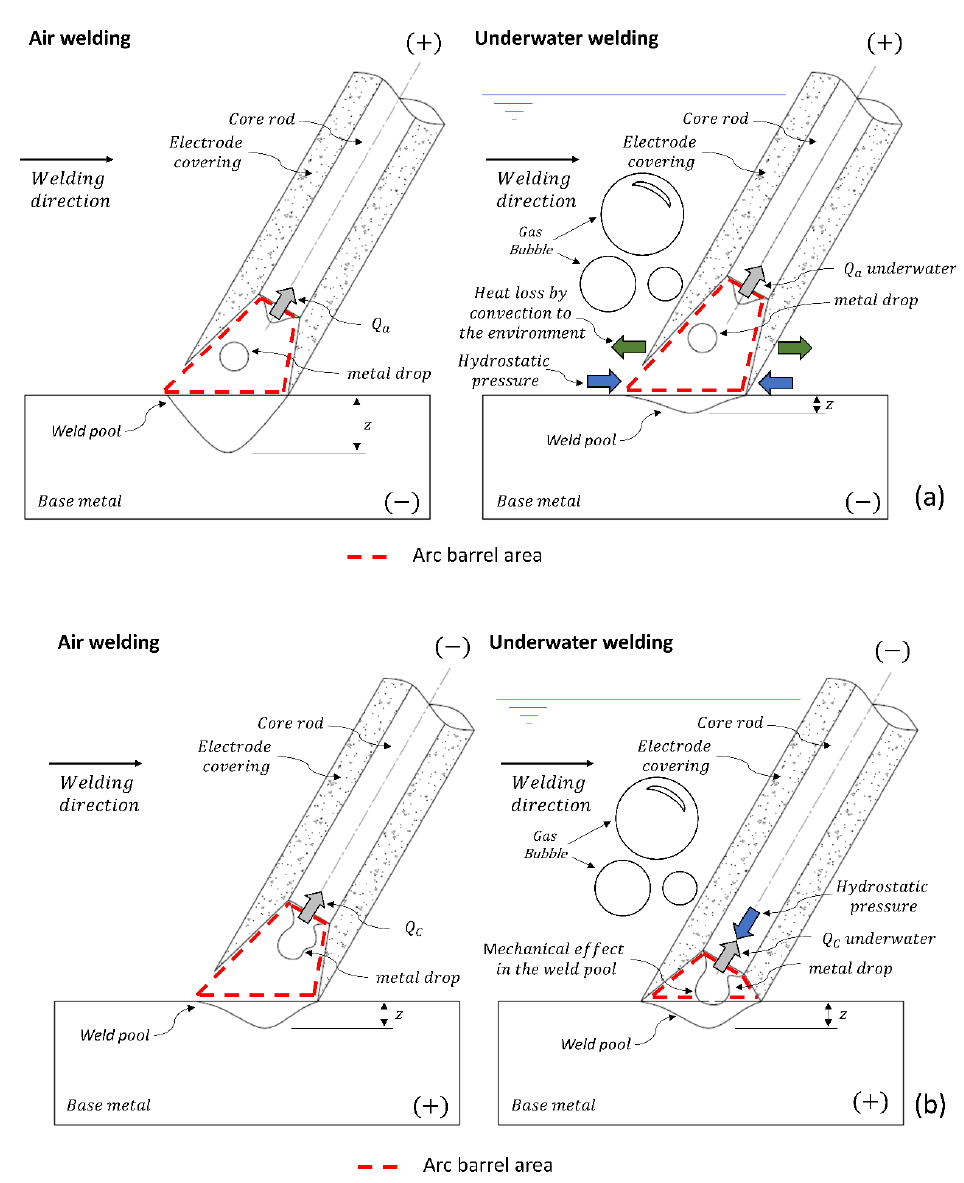
Figure 12. Schematic illustration of the effect of pressure on the arc phenomenon of UWW configured in reverse polarity (DCEP) ( a ) and direct polarity (DCEN) ( b ). Qa = heat generated in the anodic zone, Qc = heat generated in the cathodic zone, z = weld penetration.